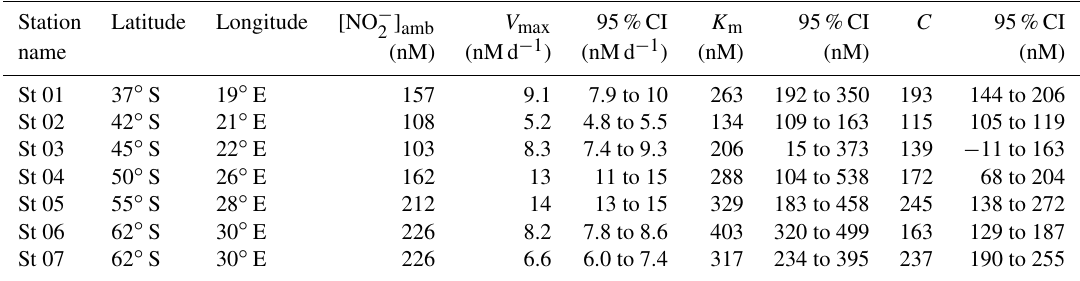
Table 1. Kinetic parameters ( V max , K m , and C ) associated with NO − oxidation experiments conducted across the western Indian sector of 2 the Southern Ocean in winter 2017. Included here are the best fit and 95% confidence interval (CI) for each kinetic parameter, derived using a nonlinear, least-squares optimization method (SciPy lmfit package, Python